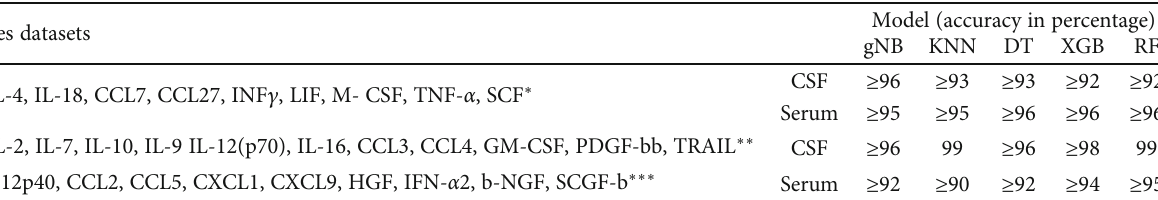
Table 3: Di ff erent model accuracy of MS diagnosis.